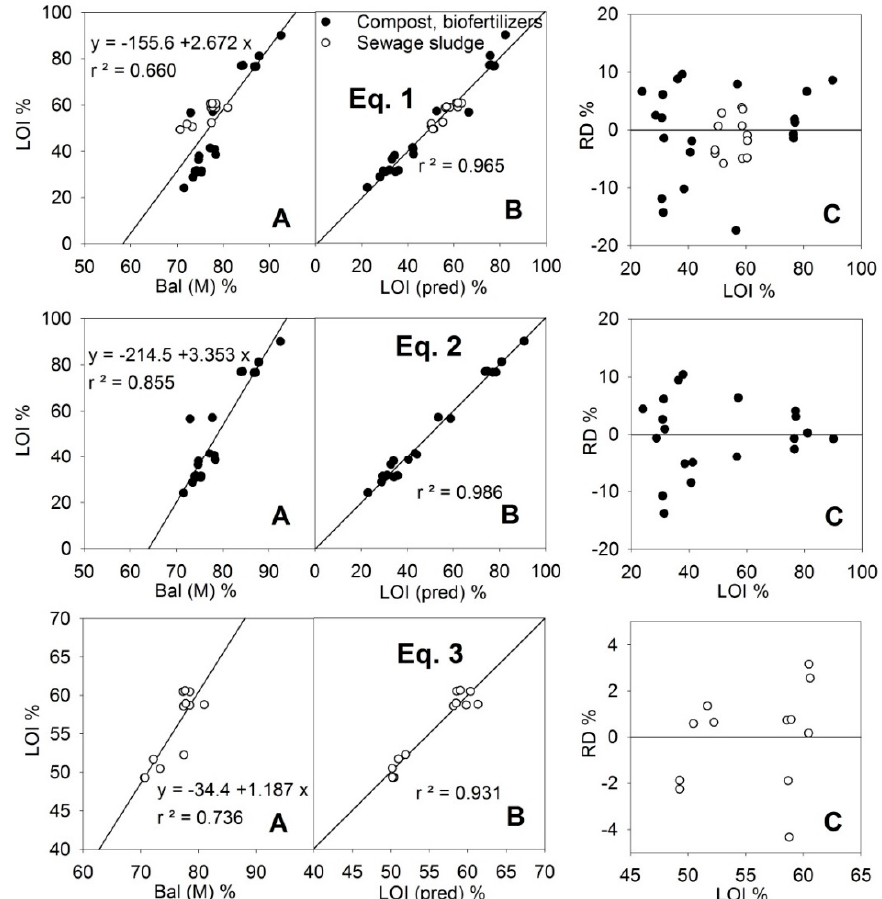
Figure 1. Relationships of Bal readings (di ff erence to 100% of the sum of all measured elements) using PXRF and the LOI (loss on ignition) content in training samples of organic amendments ( A ). Adjustment of LOI predicted values using Equation (1): [LOI(pred)] = 0.998[Bal] − 0.248[Si(M)] − 0.176[Ca(M)],